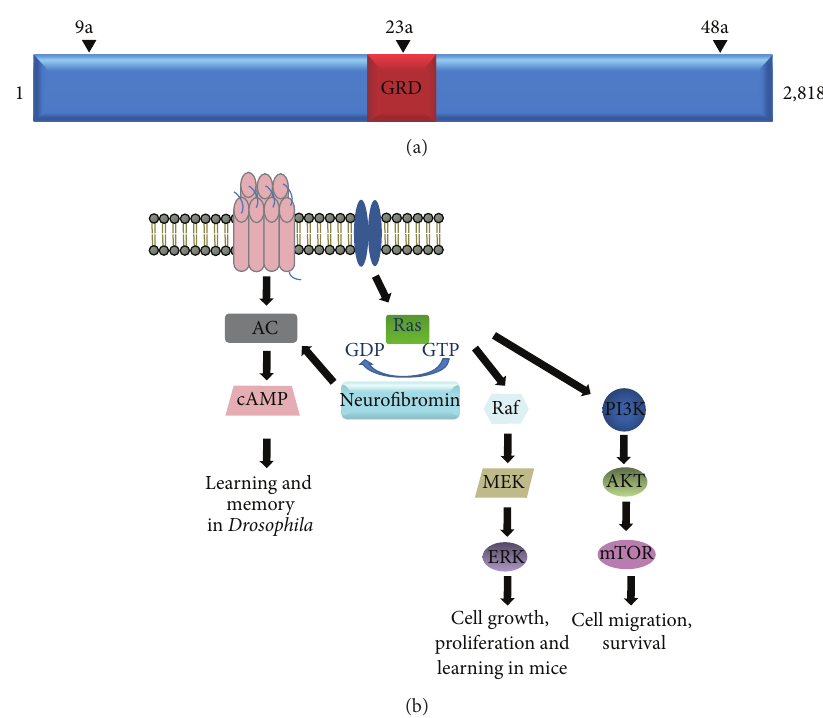
Figure 3: Neurofibromin structureand function. (a) Neurofibromin is a 2,818-amino-acid cytoplasmic protein with three alternatively spliced exons (9a, 23a, and 48a) and a central GAP-related domain (GRD). GAPs are negative regulators of RAS by accelerating the conversion of activeGTP-boundRAStoitsinactiveGDP-boundform.(b)LossofneurofibrominfunctionleadstoincreasedRASpathway(RAF/MEK/ERK or PI3K/AKT/mTOR) signaling as well as reduced cAMP